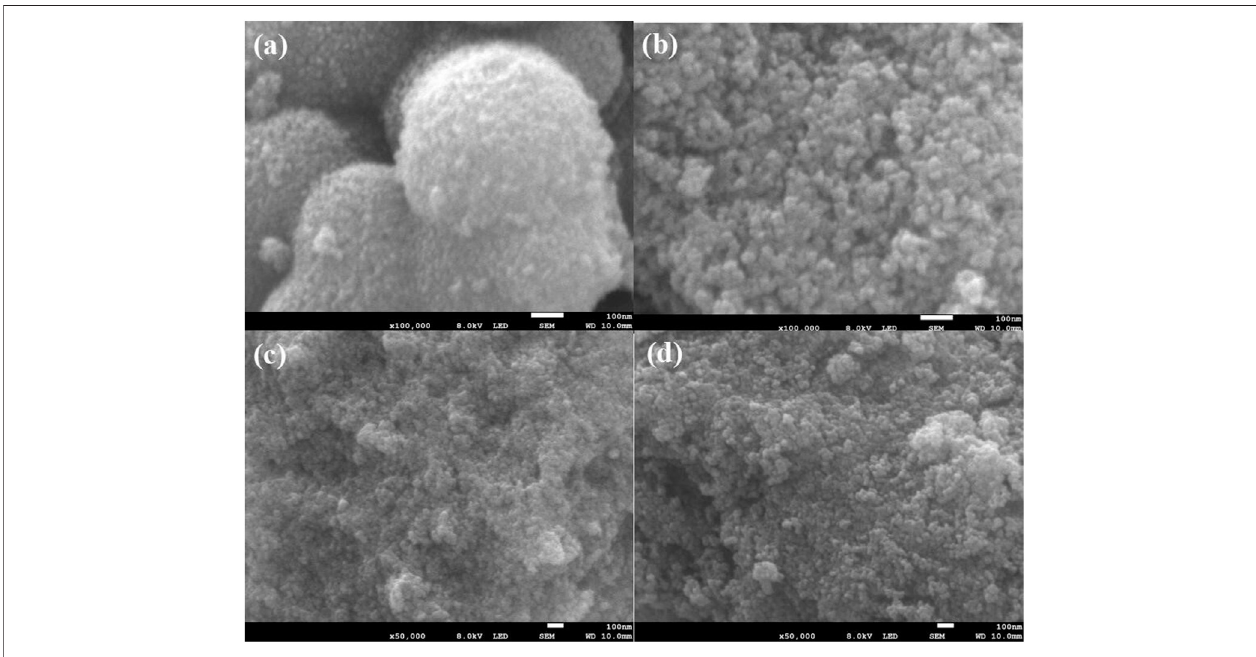
FIGURE 3 | SEM image of TiO 2 (A) , Phen/TiO 2 (B) , NO 2 -Phen/TiO 2 (C) , and NH 2 -Phen/TiO 2 (D) .